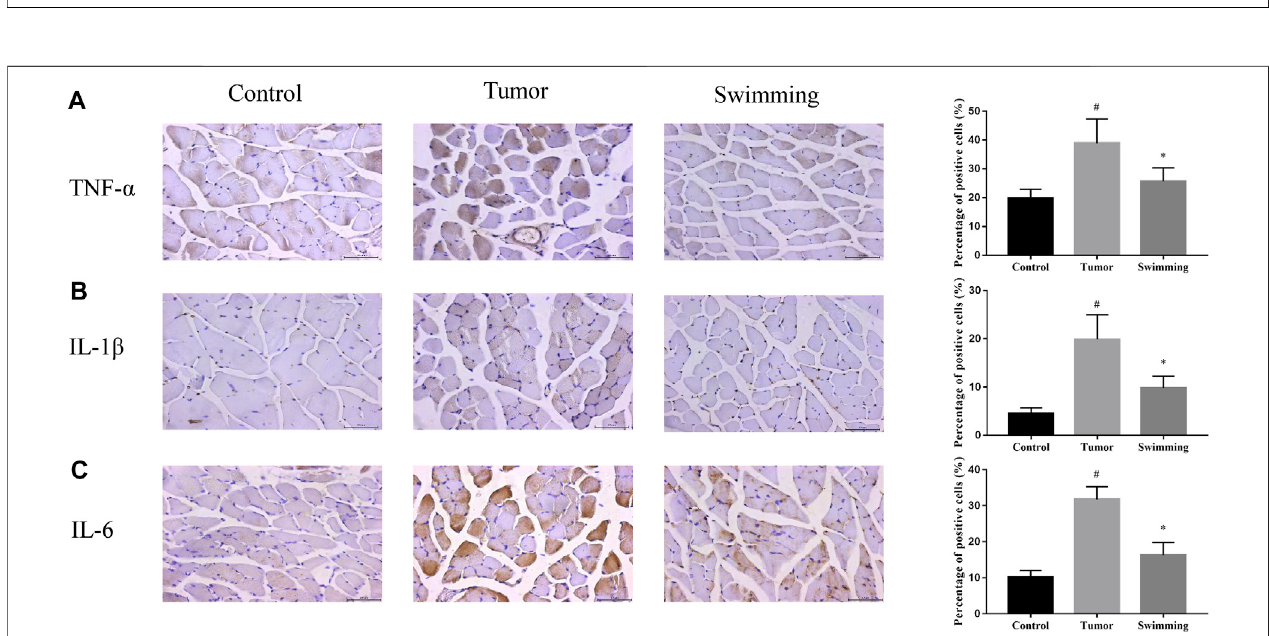
FIGURE 5 | Effects of swimming on level of in fl ammatory cytokines in quadriceps muscle tissues. The protein levels of (A) TNF- α , (B) IL-1 β and (C) IL-6 in quadriceps muscle tissues of mice from each group was determined by IHC analysis. The images were taken at a magni fi cation of × 400 by microscopy. The cells with brown staining were de fi ned as positive stained cells. Data were presented as mean ± SD. # p < 0.05 vs . Control group; * p < 0.05 vs . Tumor group.